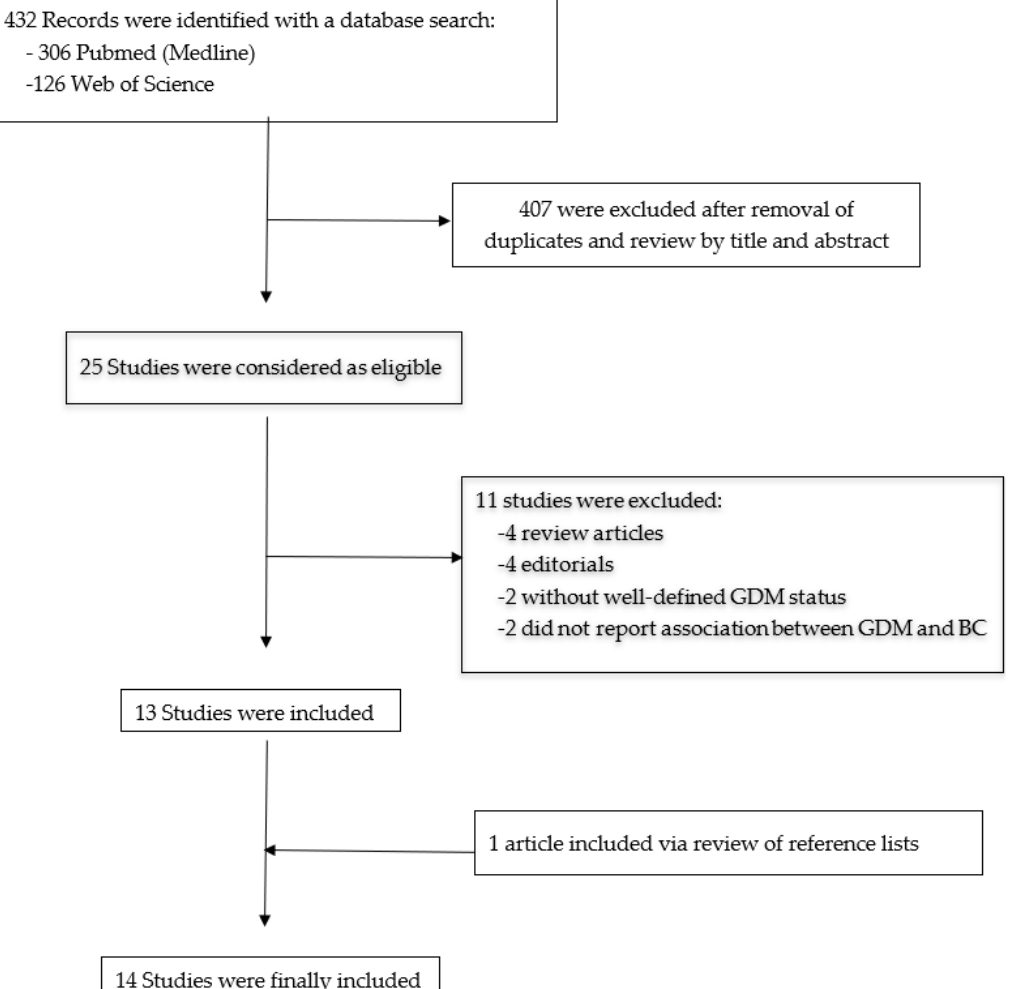
Figure 1. Flow diagram of the article selection process. GDM: gestational diabetes mellitus; BC: breast cancer.